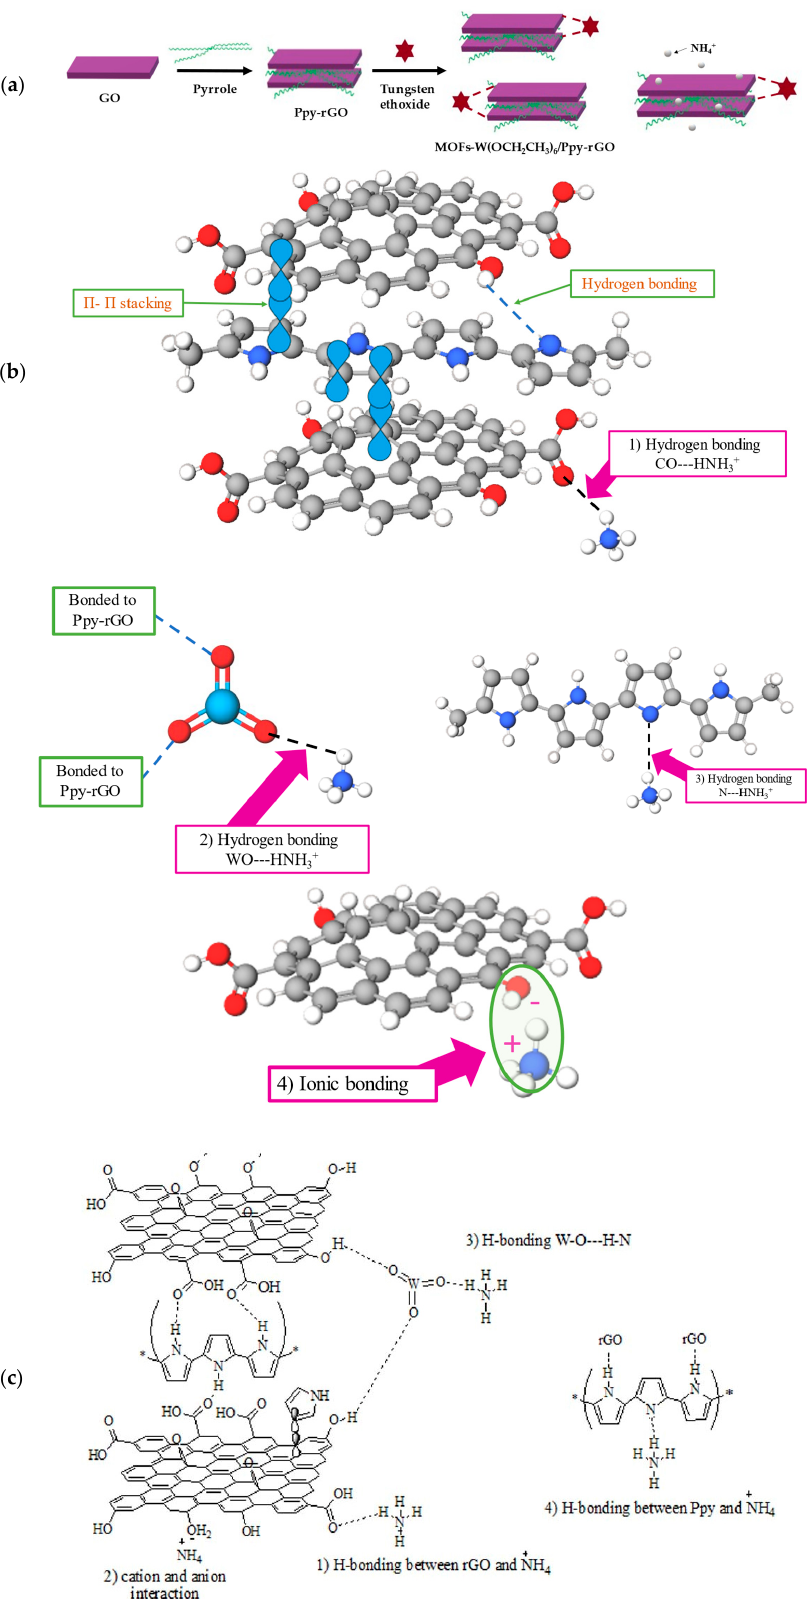
Figure 5. Schematic illustration of the ( a ) preparation of MOFs-W(OCH 2 CH 3 ) 6 /Ppy-rGO nanocrystal and detection of ammonium ions, ( b , c ) multiple ways of ion sensing of MOFs-W(OCH 2 CH 3 ) 6 /Ppy- rGO nanocrystal upon detection of ammonium ions. There are many transduction techniques for NH 4+ ion detection, such as potentiome- try, di ff erential pulse voltammetry, square-wave voltammetry, colorimetry, amperome- try, conductometry, impedance spectrometry, spectrophotometry, fi eld-e ff ect transistors (FET), and CV. Common reagents used to detect NH 4+ ions are Nessler, indophenol blue (IPB), Berthelot, and Riegler to be used in the spectrophotometry technique. This tech- nique provides highly accurate data and presents obvious color changes with the presence of NH 4+ ions, as shown in Table S8 [7–9,59,63–69]. However, the reagents used have a negative e ff ect on the environment, as most of them are toxic and corrosive [70]. This op- tical approach also requires complicated sample pretreatment and experimental opera- tions [71]. Another approach will be using a FET-based sensor, which is very convenient due to its fast measurement capabilities, is portable, and allows operation under harsh and corrosive environmental conditions [72]. However, the consistency and reliability of sensing performance will be poor due to the corrosion of electrodes. 4. Conclusions In summary, facile synthesis of MOFs-W(OCH 2 CH 3 ) 6 /Ppy-rGO nanocrystals has been demonstrated through chemical reduction and hydrothermal techniques. The com- bination of graphene in tungsten-MOF provides high current mobility for improved NH 4+ ion detection. The developed electrochemical sensor demonstrates high sensitivity as ob- served from the linear increment in the resistivity of the MOFs-W(OCH 2 CH 3 ) 6 /Ppy-rGO electrode against increasing concentrations of NH 4+ ions. The MOFs-W(OCH 2 CH 3 ) 6 /Ppy- rGO electrode exhibited excellent stability towards NH 4+ ion detection and good recovery